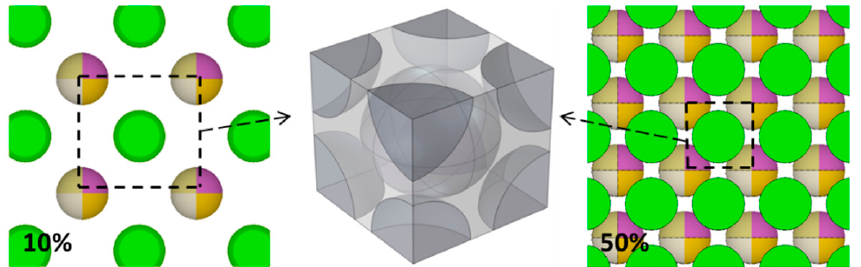
Figure 2. Two-dimensional BCC Model (10 vol.% on the left and 50 vol.% on the right) and three- dimensional BCC Model unit.